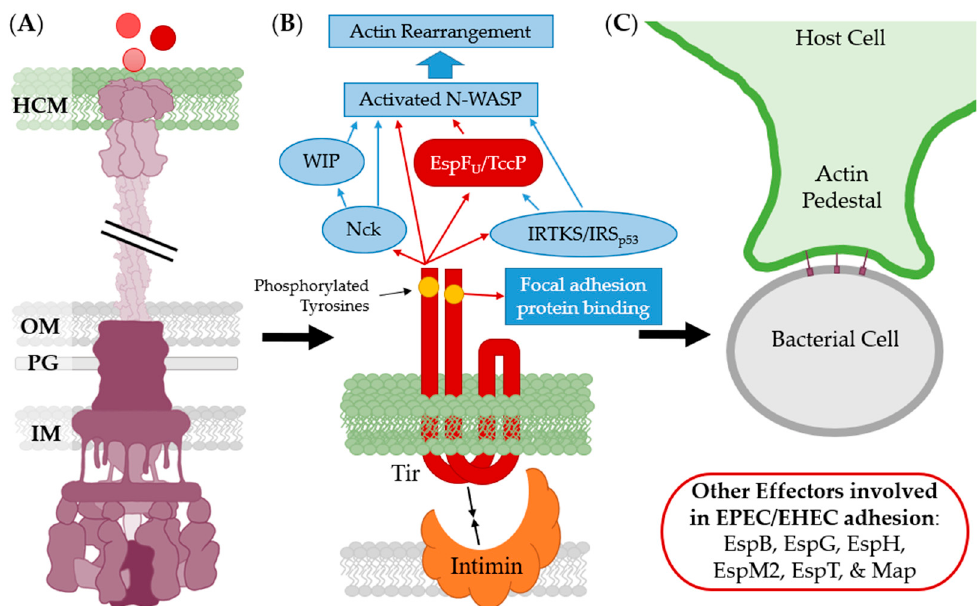
Figure 18. Process of intimate adhesion via Tir-intimin binding in pathogenic E. coli . ( A ) Pathogen contacts the host cell via T3SS and secretes effectors (red), including Tir; ( B ) Tir incorporates into the host membrane and binds to intimin on the bacterial membrane. The N-terminus of Tir binds to focal adhesion proteins within the host. Tir’s C-terminus interacts with multiple host factors (blue) to cause actin rearrangement; ( C ) Actin rearrangement causes the formation of the characteristic actin pedestal around the bacterial cell. Modified from [213]. Abbreviations: OM, outer membrane; PG, peptidoglycan; IM, inner membrane; HCM, host cell membrane.